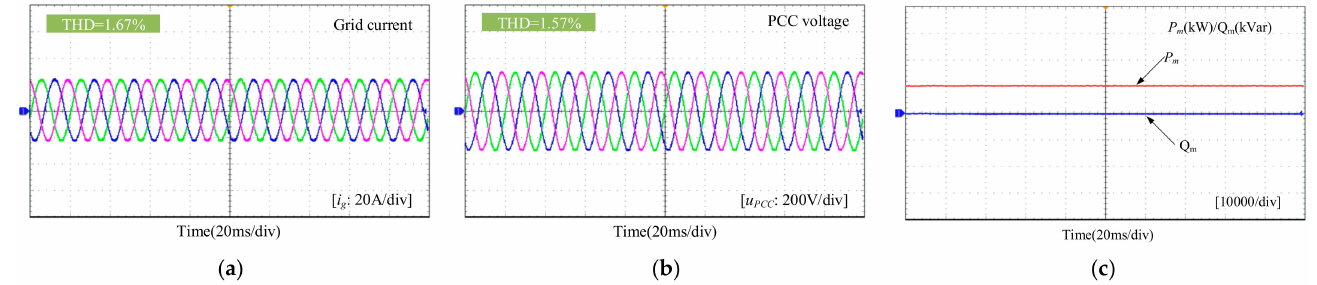
Figure 16. Experiment results with the impedance reshaping control strategy when SCL = 100%. ( a ) Grid current, ( b ) PCC voltage, ( c ) active and reactive power.